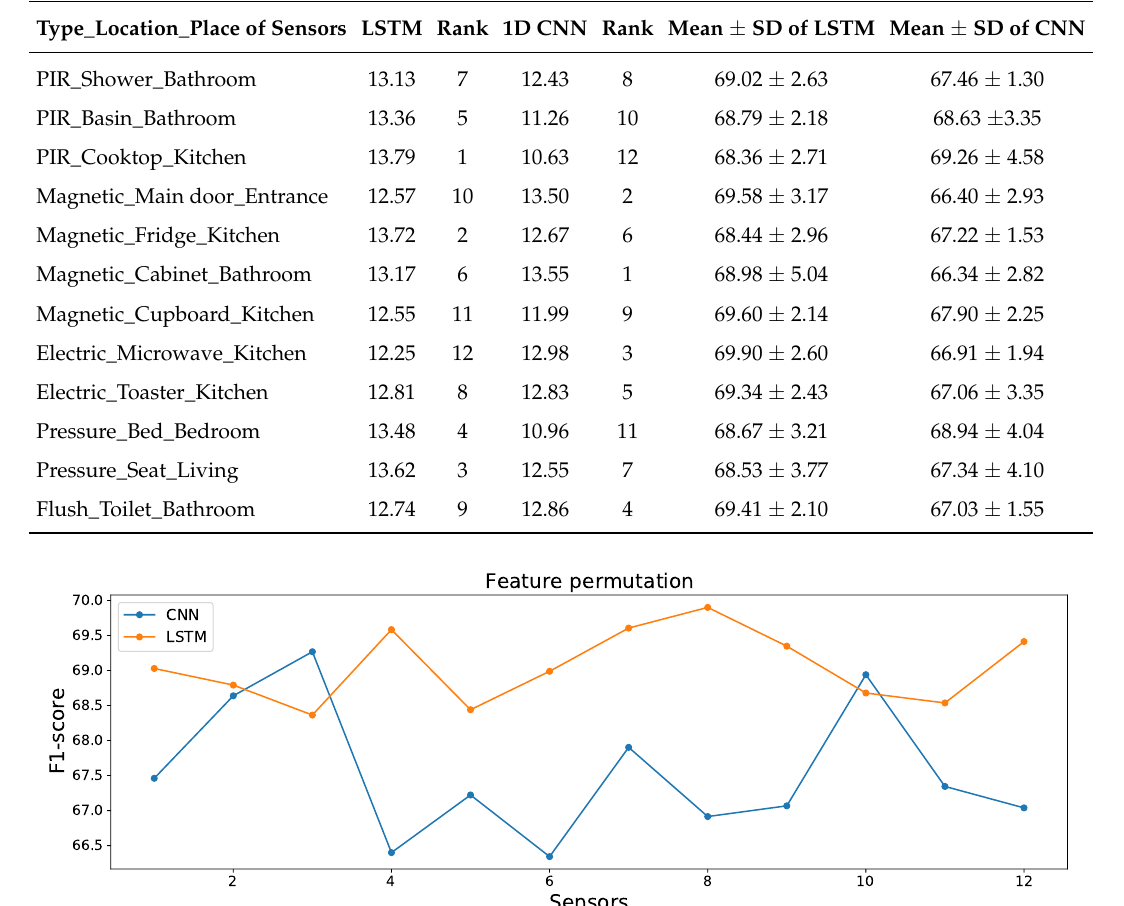
Figure 10. Results of mean F1-score for feature permutation of 12 sensors with N = 12 runs from Ordonez Home